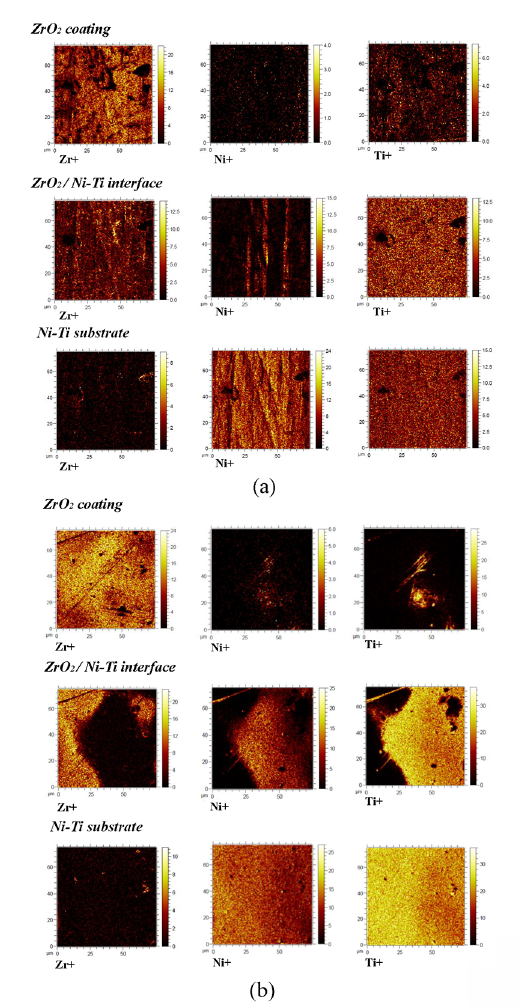
Figure 8. ToF-SIMS 2D reconstructed ion images of Ni-Ti wire coated with ZrO2 with the electrodeposition time of 2400 seconds: (a) without prior electropolishing; and (b) with prior